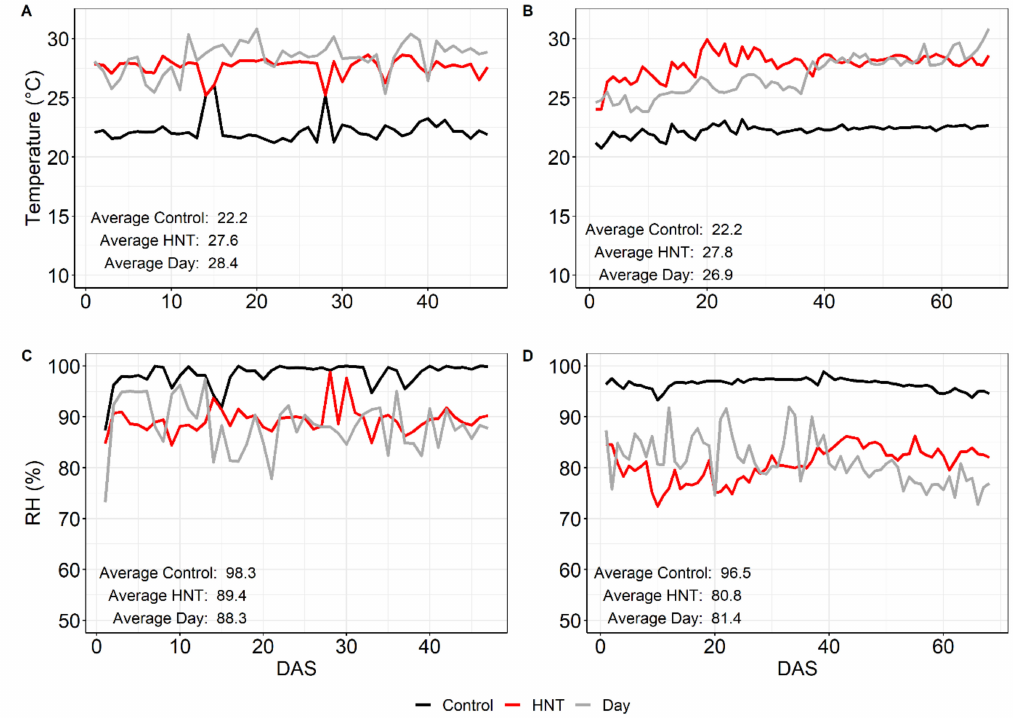
Figure 1. Average temperature ( A , B ) and relative humidity (RH) ( C , D ) during the night (6 p.m.–6 a.m.) in the wet season (WS) ( A , C ) and dry season (DS) ( B , D ) under control and HNT conditions, measured till the end of sampling at 50% flowering. For comparison, day temperature and humidity are included (grey lines). Measurements, which were done every 30 min, were averaged. DAS—Days after stress; WS—wet season; DS—dry